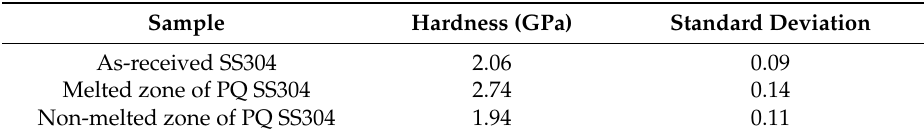
Table 2. Vickers hardness test results.